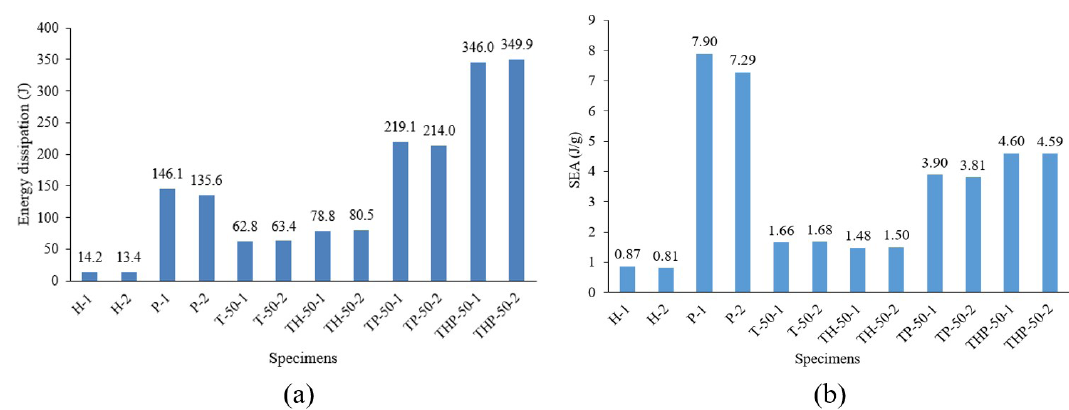
Figure 13. A graphical comparison of: (a) energy dissipation of tested specimens; (b) specific energy absorption (SEA) of